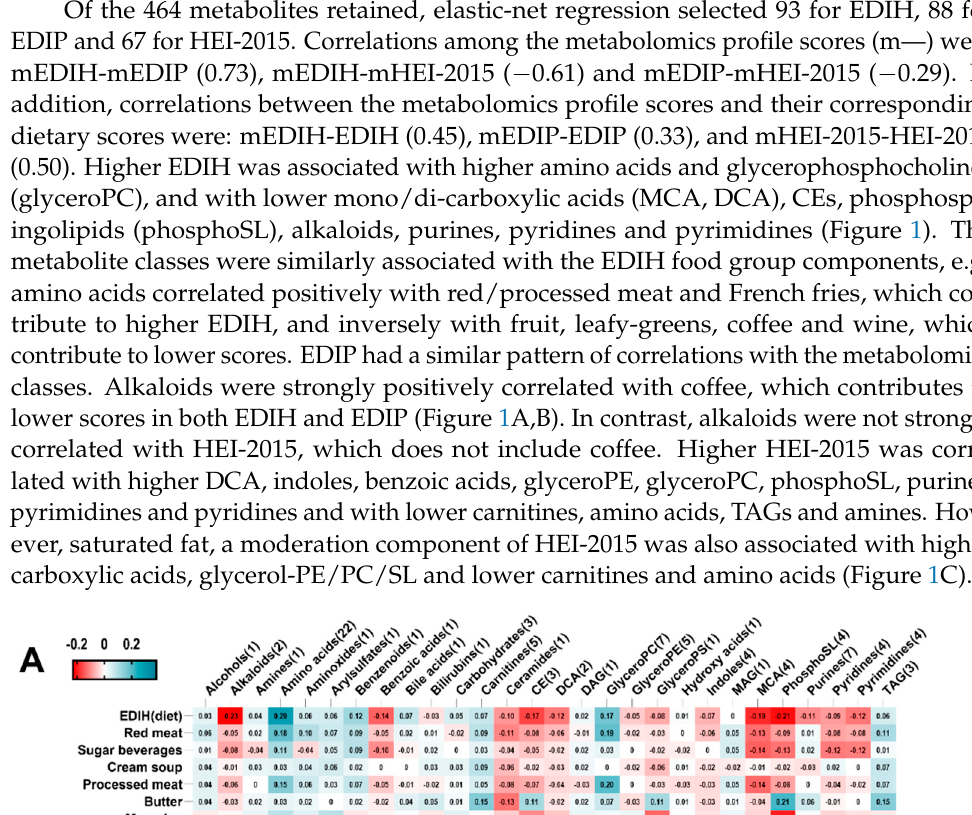
Figure 1. Correlations between dietary pattern food group components and metabolomics class scores. ( A ) Correlations between EDIH food group components and EDIH metabolomic class scores.